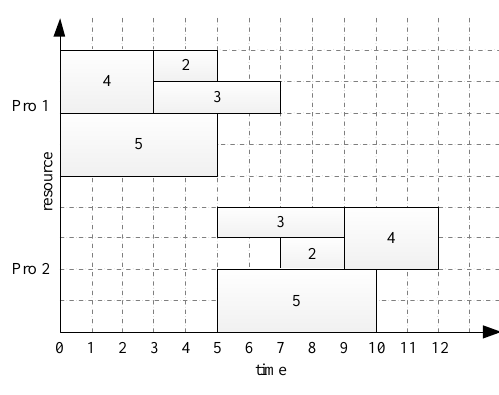
Fig.3. Schedule 2 for a two-project network